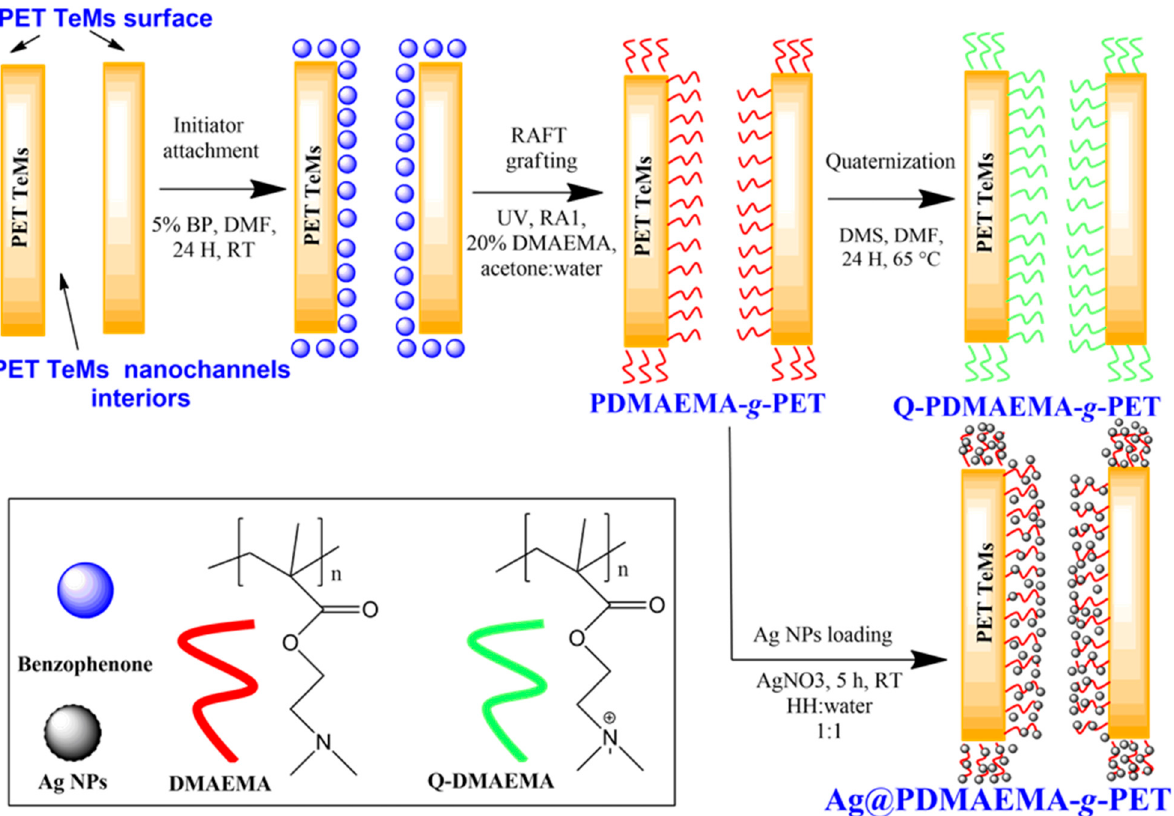
Figure 1. Simplified scheme for the preparation of hybrid track-etched membranes grafted by well-defined poly(2-(dimethylamino)ethyl methacrylate) brushes and loaded with silver nanoparticles.